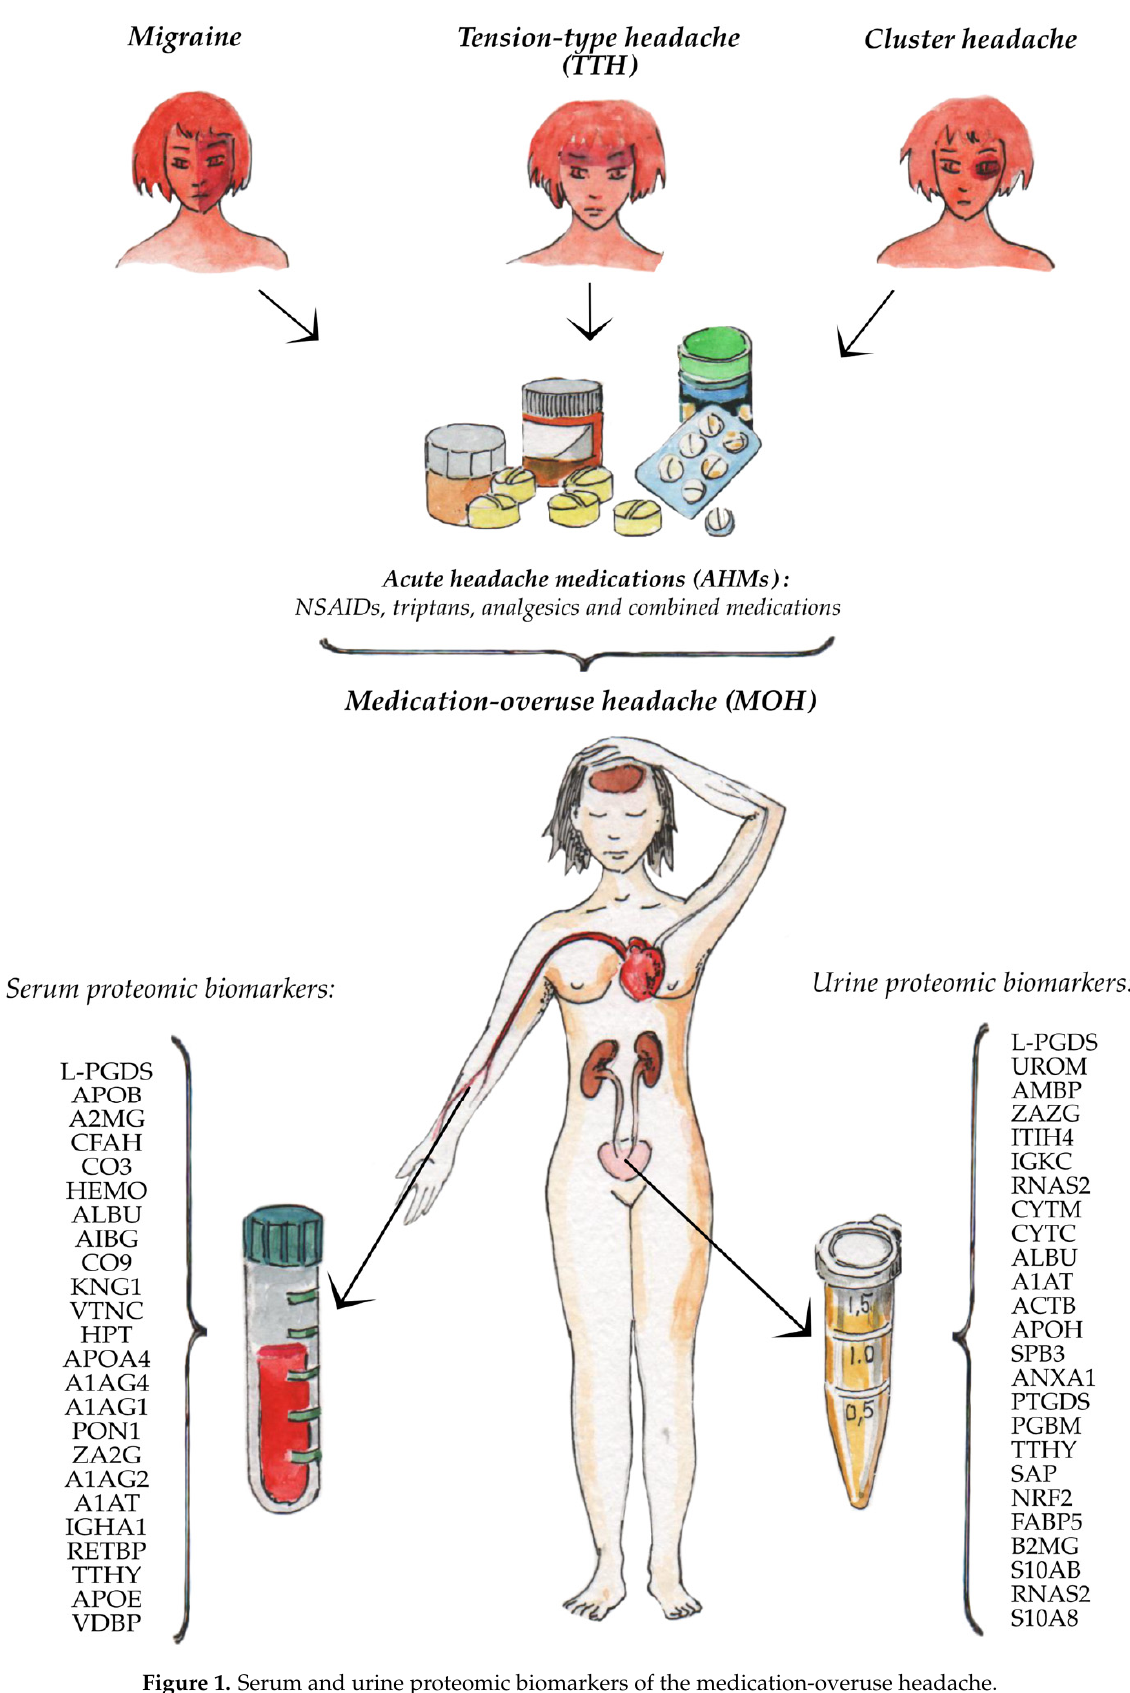
Figure 1. Serum and urine proteomic biomarkers of the medication-overuse headache.